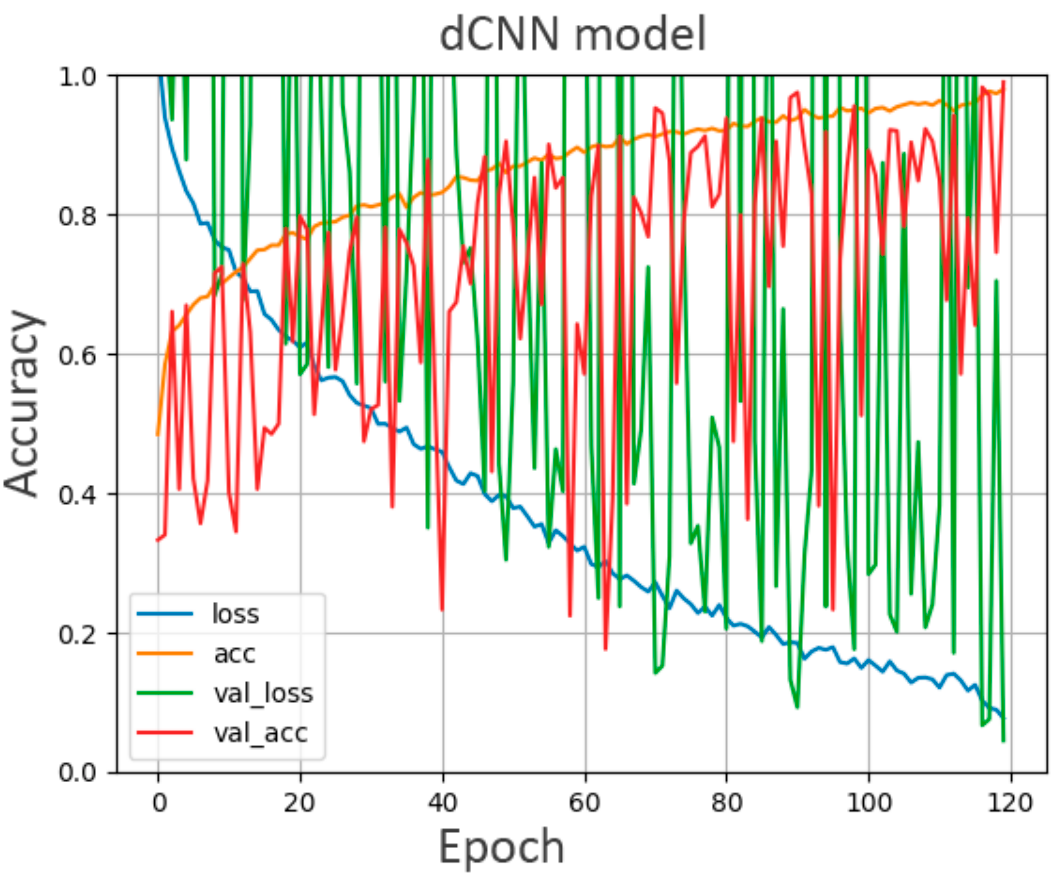
Figure 2. Training accuracy, validation accuracy, and loss curves for the dCNN model vs. the number of epochs for the training and validation data.